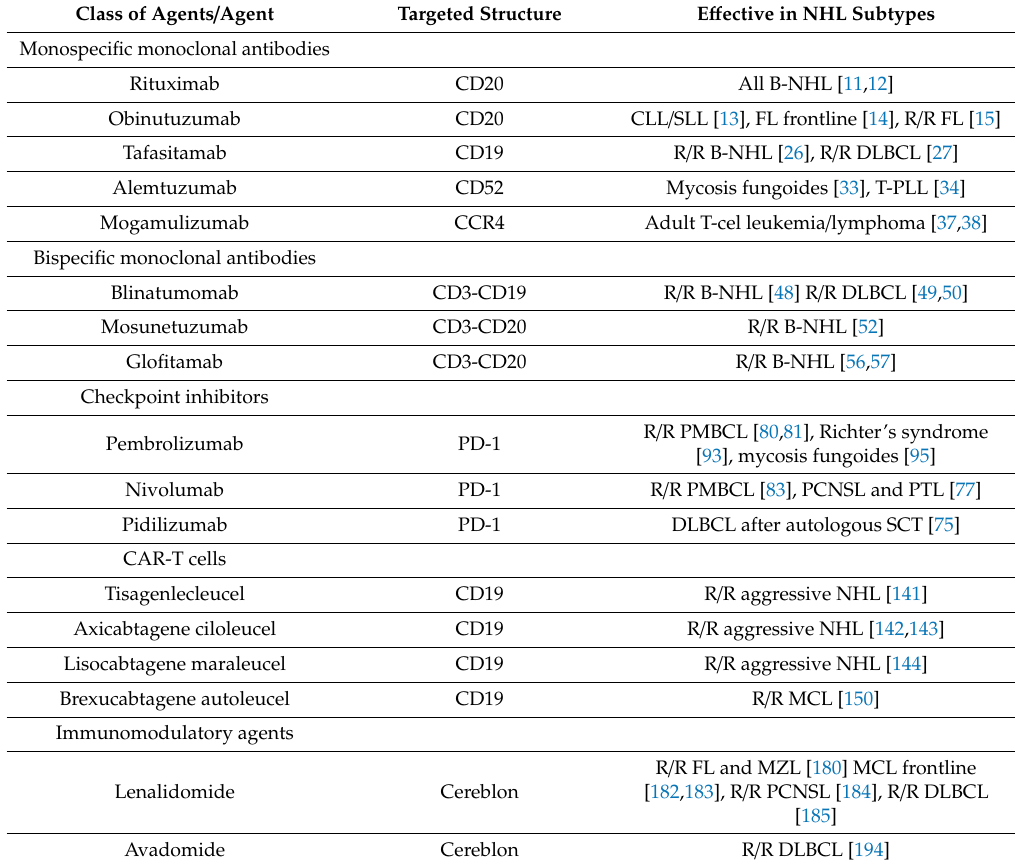
Table 10. Selected immunotherapy approaches clinically approved for treatment of